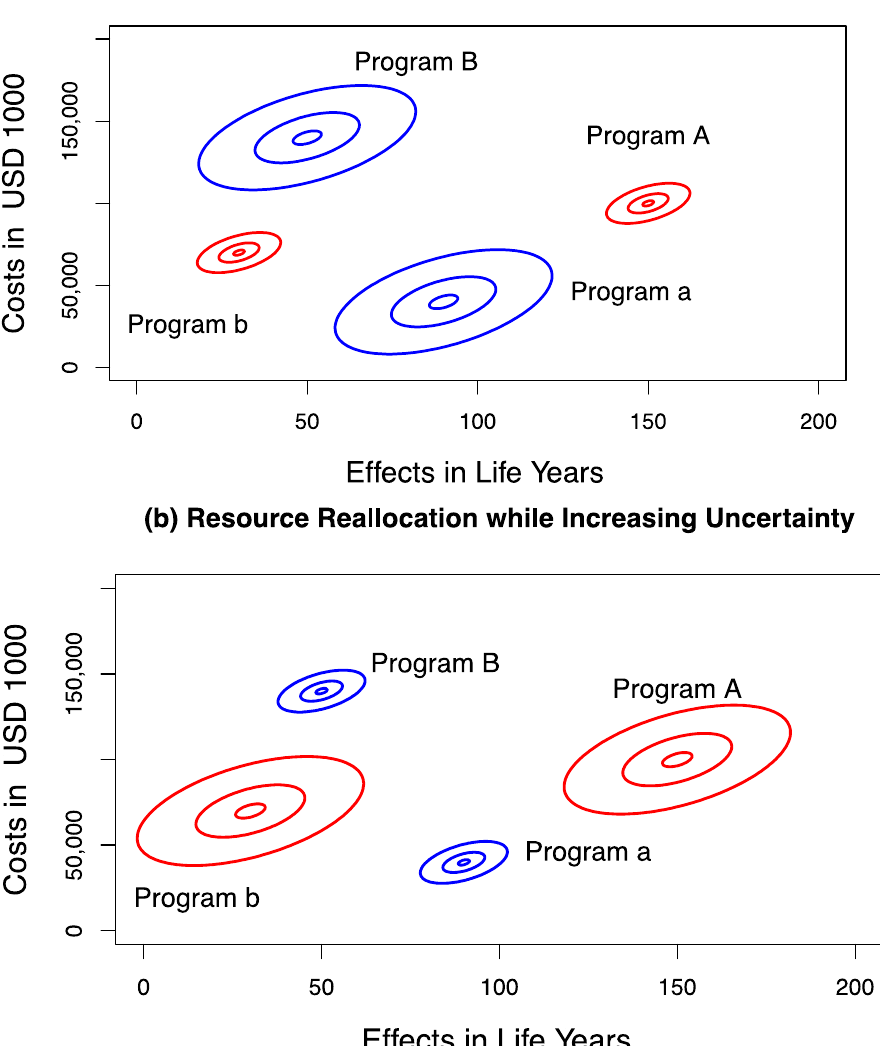
Figure 3. Joint distribution of net costs and net effects on the decision-making plane (DMP). The distribution of net costs and effects on the DMP were estimated by sampling 10,000 times from the